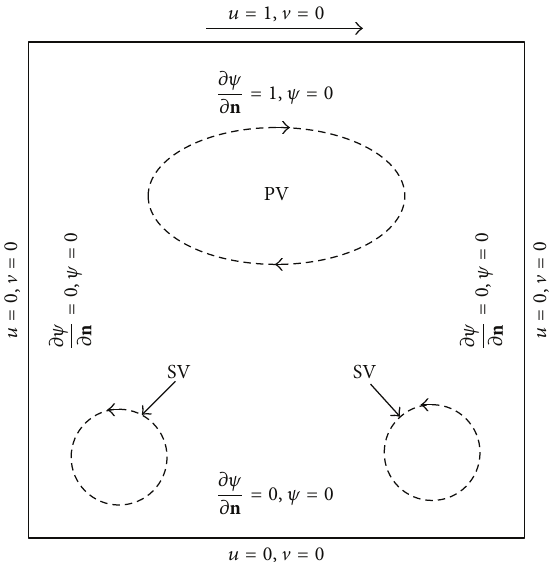
Figure 6: Lid-driven cavity flow.